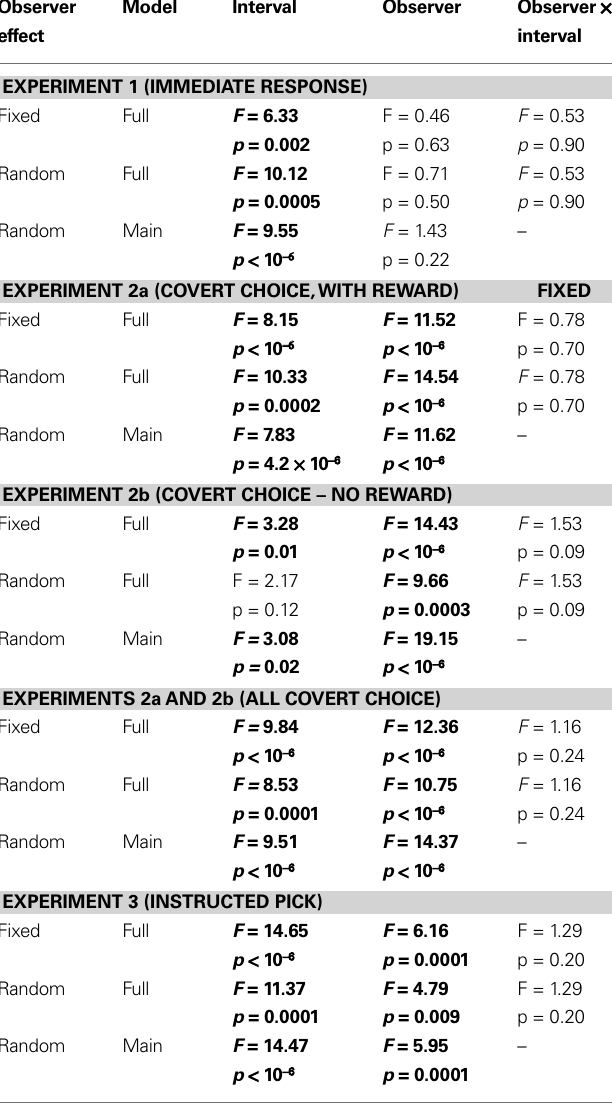
Table 1 | Overview over 2-factor ANOVA